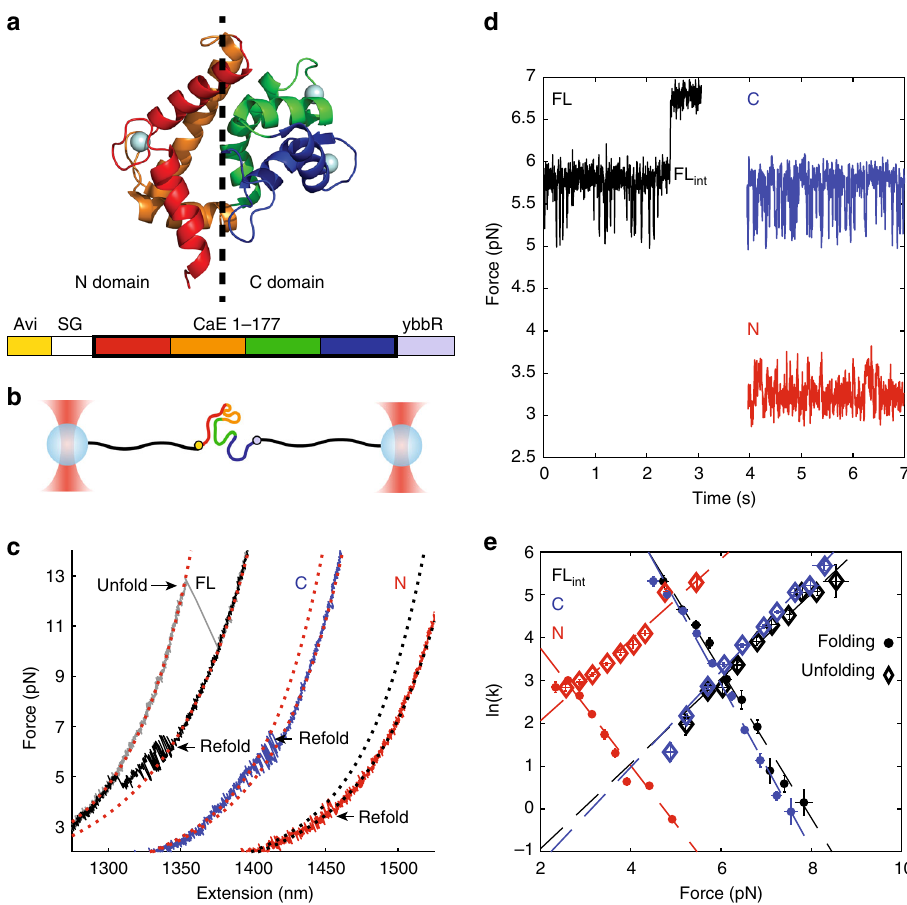
Fig. 1 Full-length calerythrin folds through the C domain. a The NMR structure of calerythrin (PDB: 1NYA 20 ). EF 1, 2, 3, and 4 are red, orange, green, and blue, respectively. The protein sequence contains an Avi tag at the N terminus and ybbR tag at the C-terminus. b The geometry in OT is shown, with 2 kb of DNA on each side of the protein. c Force – extension curves of the FL, N, and C domain samples, offset in extension. The WLC model of DNA + protein is shown as dotted red lines, except for N domain, which is dotted black. The protein WLCs correspond to lengths of 177, 75, and 90 amino acids for FL, C, and N. The FL protein unfolds cooperatively (gray) and refolds in two steps (black). The C (blue) and N (red) domains fold reversibly in one step; for clarity only the refolding curves are shown. d Passive of the FL, C, and N constructs (offset in time). In all cases, the lowest observed force is the unfolded state, and then transitions are observed to a folded state. For FL (black), the fi rst transition is FL int and the highest transition is the full-folded structure. The N and C fold to their one-domain structures. e The kinetics of folding (circles) and unfolding (diamonds) for FL int match the kinetics of the C domain but are markedly different than the N domain. Error bars are standard error (SE). FL int n = 11 molecules, 116 rate measurements; C domain n = 9 molecules, 107 rate measurements; N domain n = 13 molecules, 100 rate measurements. See Supplementary Table 1 for the fi ts of the Bell model (dashed lines). See Supplementary Fig. 2 for further con fi rmation of FL int identity. Source data are provided as a Source Data fi